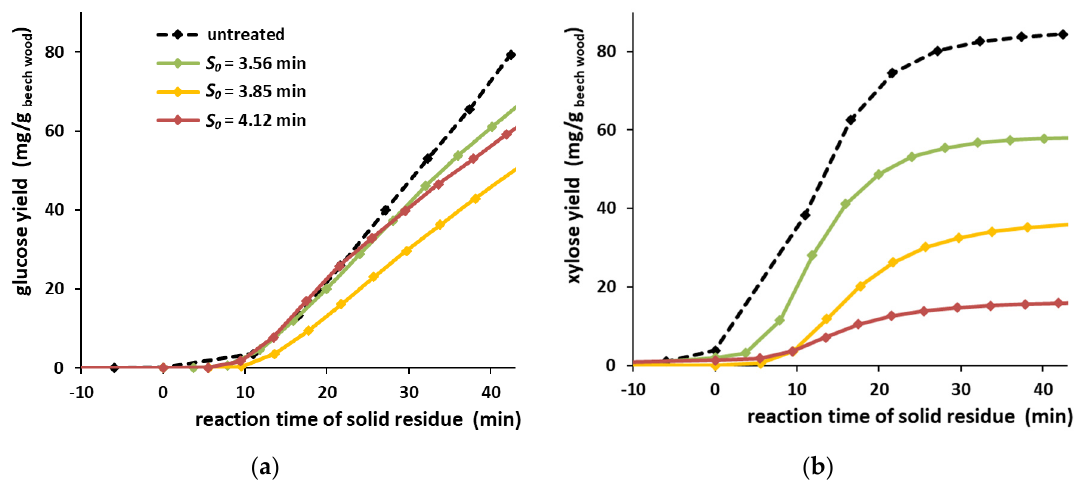
Figure 5. Cumulative yields of glucose ( a ) and xylose ( b ) during the hydrolysis of untreated beech wood or steam-exploded residue at different severity parameters S 0 , hydrolysis with 0.05 mol/L sulfuric acid at 15 mL/min flow at 180 °C, t = 0 min marks the beginning of acid hydrolysis.